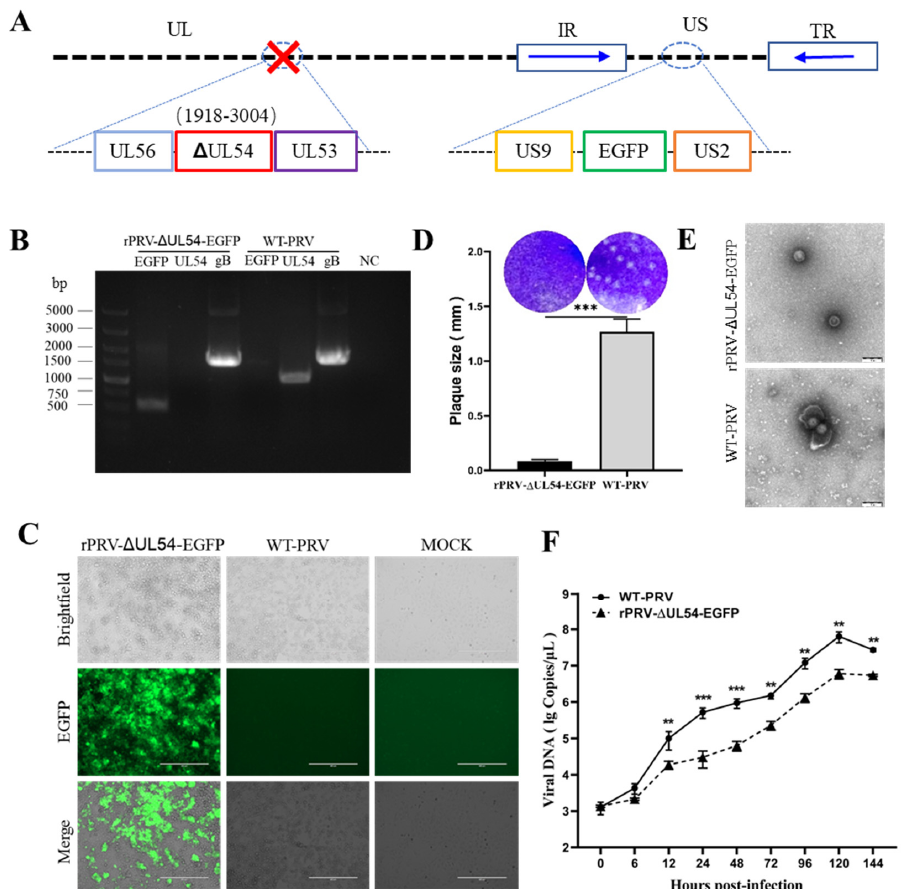
Figure 5. Generation and characterization of rPRV- ∆ UL54-EGFP. ( A ) Schematic diagram of the construction of rPRV- ∆ UL54-EGFP. Using the PRV genomic fosmid library, the UL54 deletion mutant was constructed using rPRV-EGFP as the parental strain. The relative position of the UL54 gene in the WT-PRV genome is shown on top of the red box. ( B ) PCR amplification of the UL54 , EGFP , and gB genes from the genomes of rPRV- ∆ UL54-EGFP and WT-PRV. ( C ) The green fluorescence and cytopathic effects (CPEs) in the PK-15 cells infected with rPRV- ∆ UL54-EGFP and WT-PRV at 60 h postinfection (hpi). ( D ) Plaques of rPRV- ∆ UL54-EGFP and WT-PRV in the PK-15 cells. The diameters of plaques were averaged for three independent experiments. ( E ) Transmission electron microscopy imagingof rPRV- ∆ UL54-EGFP and WT-PRV. Scale bar = 200 nm. ( F ) Multistep growth curves of rPRV- ∆ UL54-EGFP and WT-PRV in PK-15 cells. PK-15 cells were infected with rPRV- ∆ UL54-EGFP and WT-PRV (MOI = 0.01). Bars represent the means ± SDs of three independent experiments. ns: not significant ( p ≥ 0.05). ** p < 0.01, and *** p <